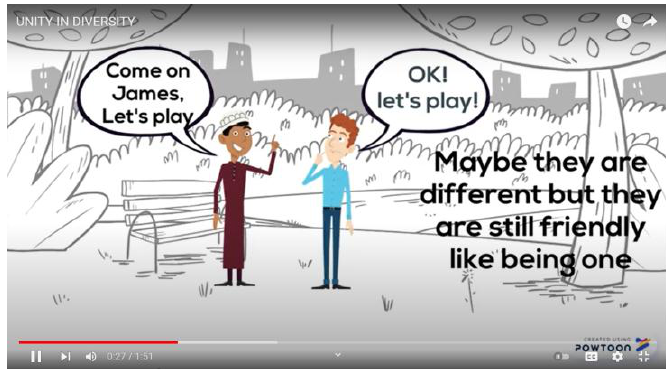
FIGURE 4 | Warm-Up Activity for Grade 6 - Unity in